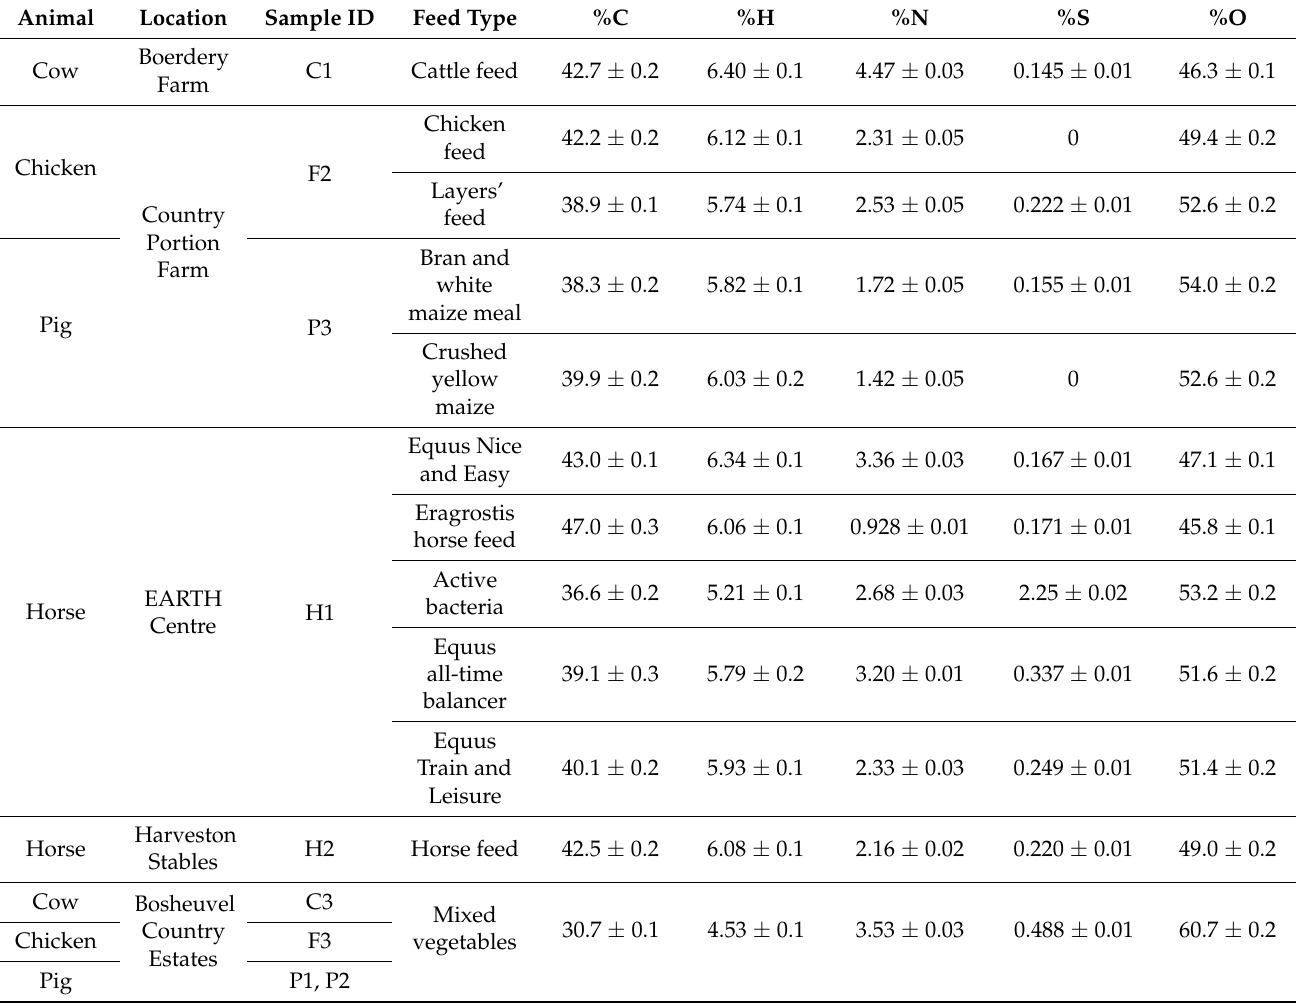
Table A1. Elemental composition of animal feeds.